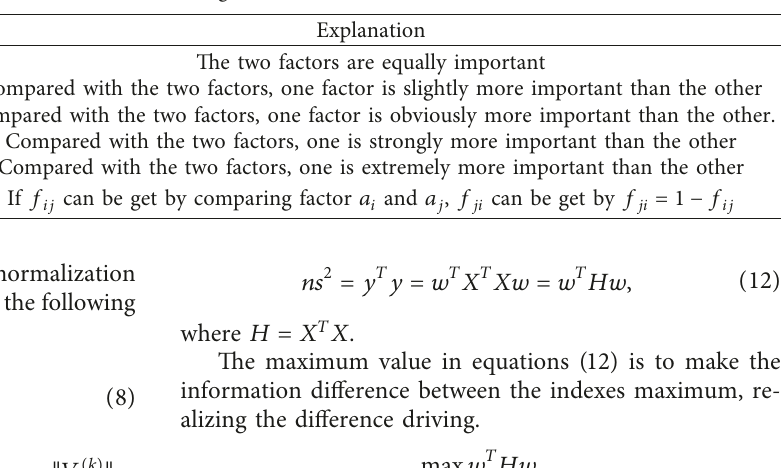
Table 2: 0.1 ∼ 0.9 Scaling